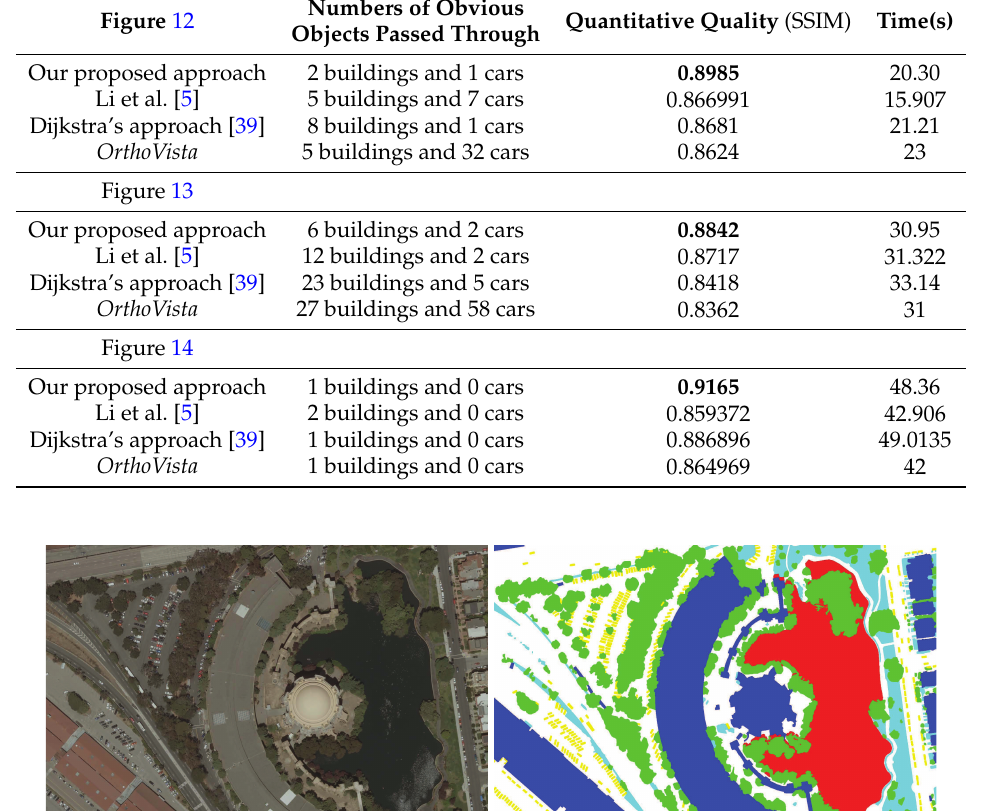
Quantitative Quality (SSIM) Time(s)